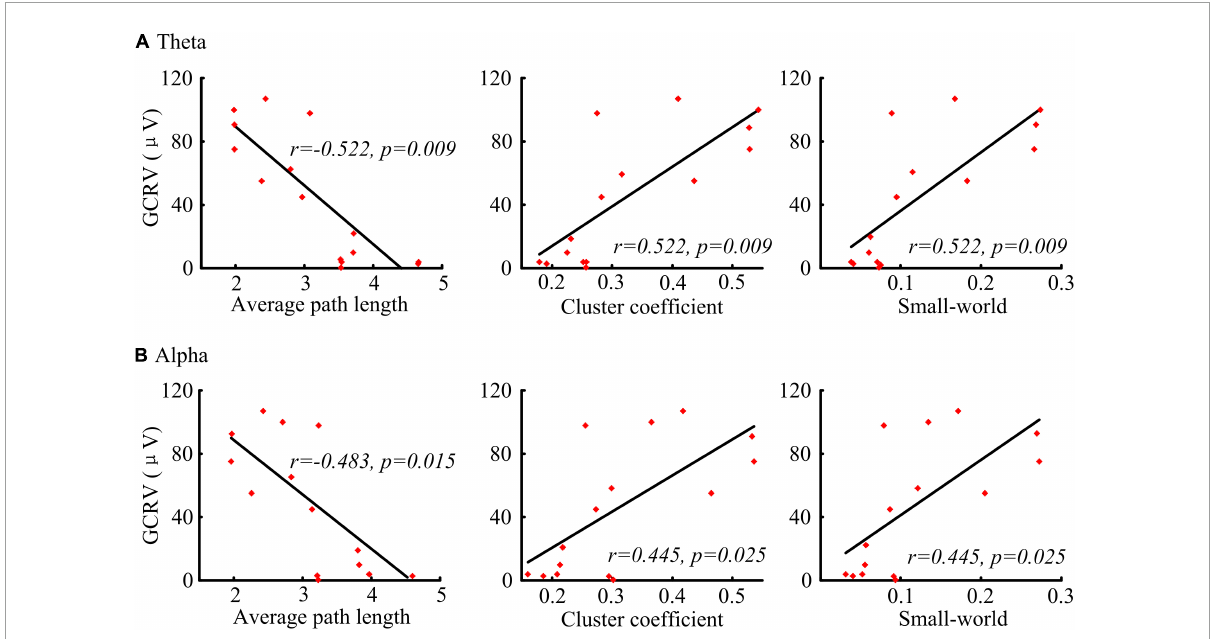
FIGURE5 Correlation (Kendall’s tau coefficient) of the graphical network parameters with the patients’ GCRV. (A) Correlation of the average path length, cluster coefficient, and small-world at theta band with the patients’ GCRV. (B) Correlation of the average path length, cluster coefficient, and small-world at alpha band with the patients’ GCRV.